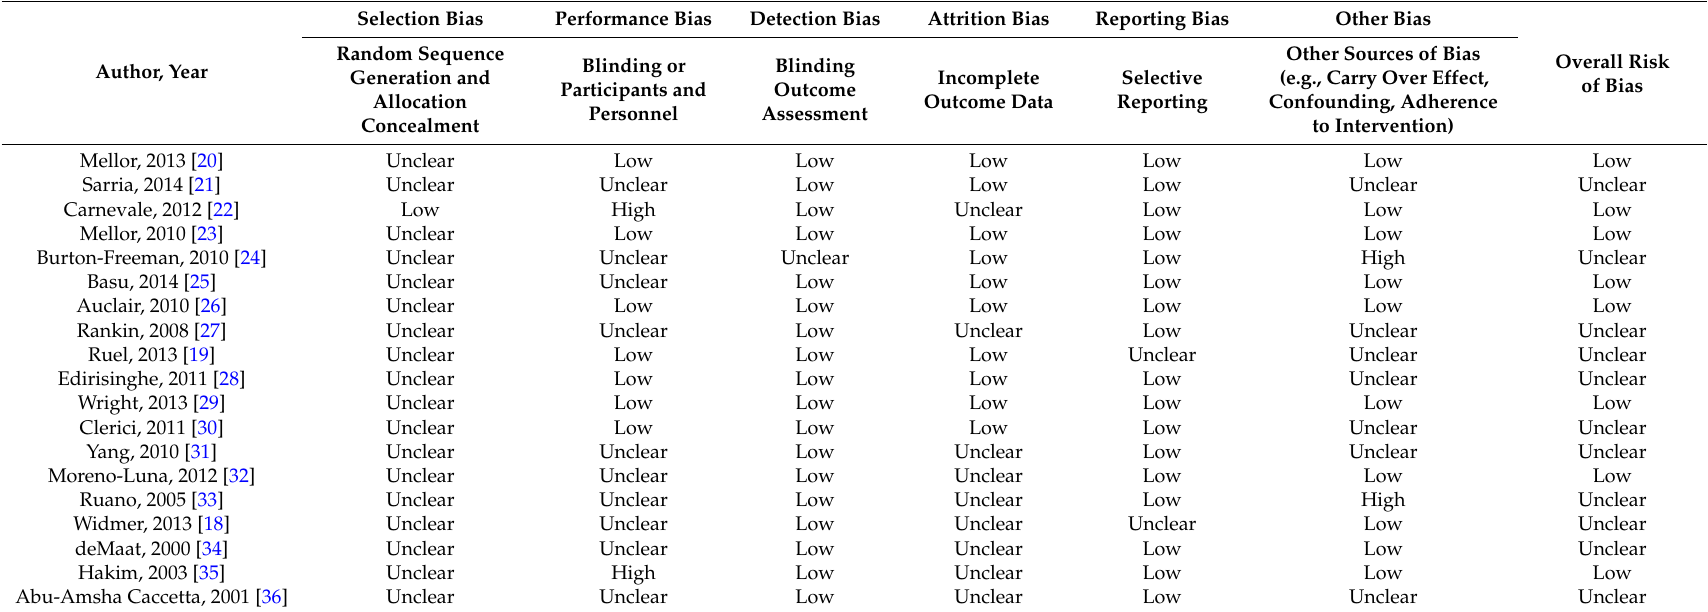
Table 2. Quality critique of trials with Cochrane Collaboration Tool for assessing risk of bias